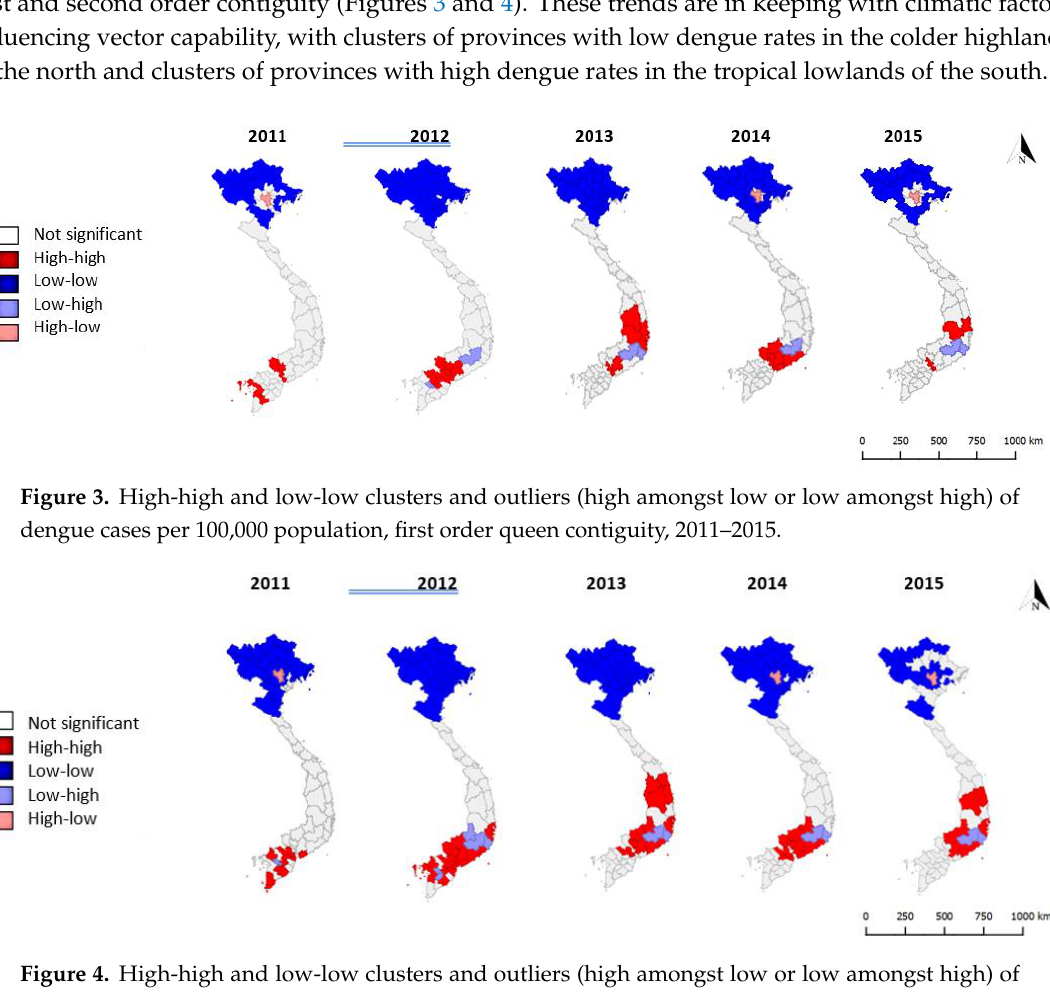
Figure 4. High-high and low-low clusters and outliers (high amongst low or low amongst high) of dengue cases per 100,000 population, second order queen contiguity, 2011–2015.